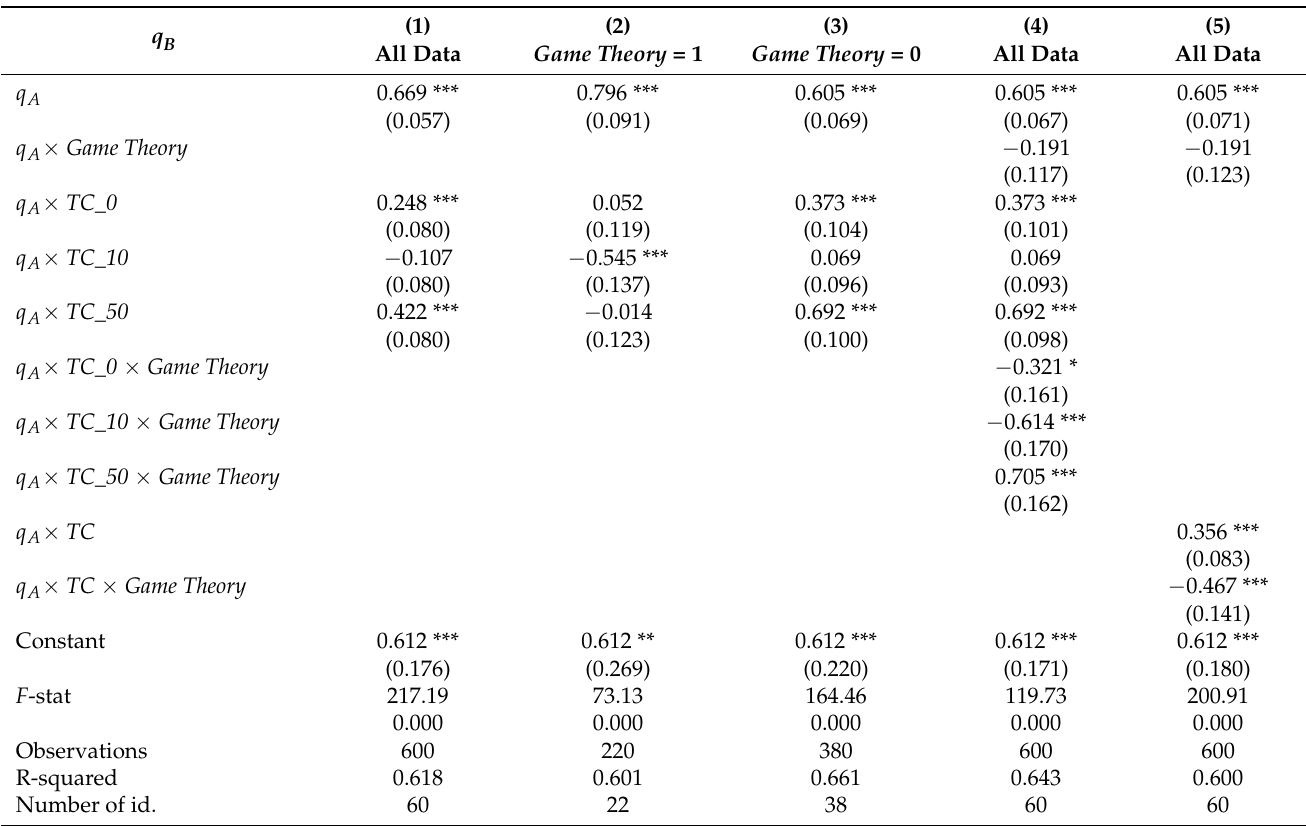
Table 6. Trustee’s